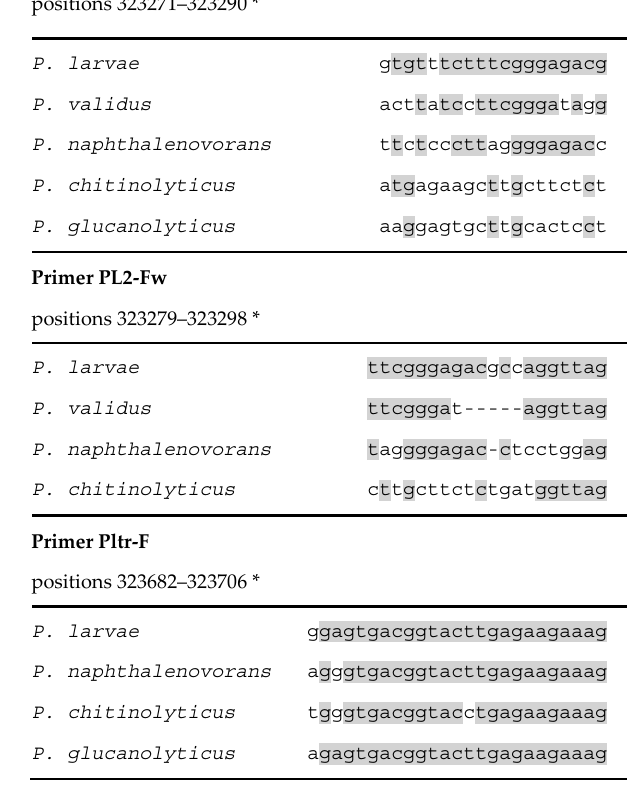
Figure 1. Sequence alignments of the annealing sites of forward primers from P. larvae targeted identification and detection qPCR assays in P. larvae and closely related or hive associated Paenibacillus species. All the types of matching observed are shown and positions matching between P. larvae and at least one of the other species are shadowed. The aligned sequences have accession numbers NR_112053, AB073189, NR_028817 and AB073203 for P. chitinolyticus , P. glucanolyticus, P. naphthalenovorans and P. validus , respectively. * Positions in the P. larvae ATCC 9545 genome GenBank Acc. n. CP019687, locus tag BXP28_01730.